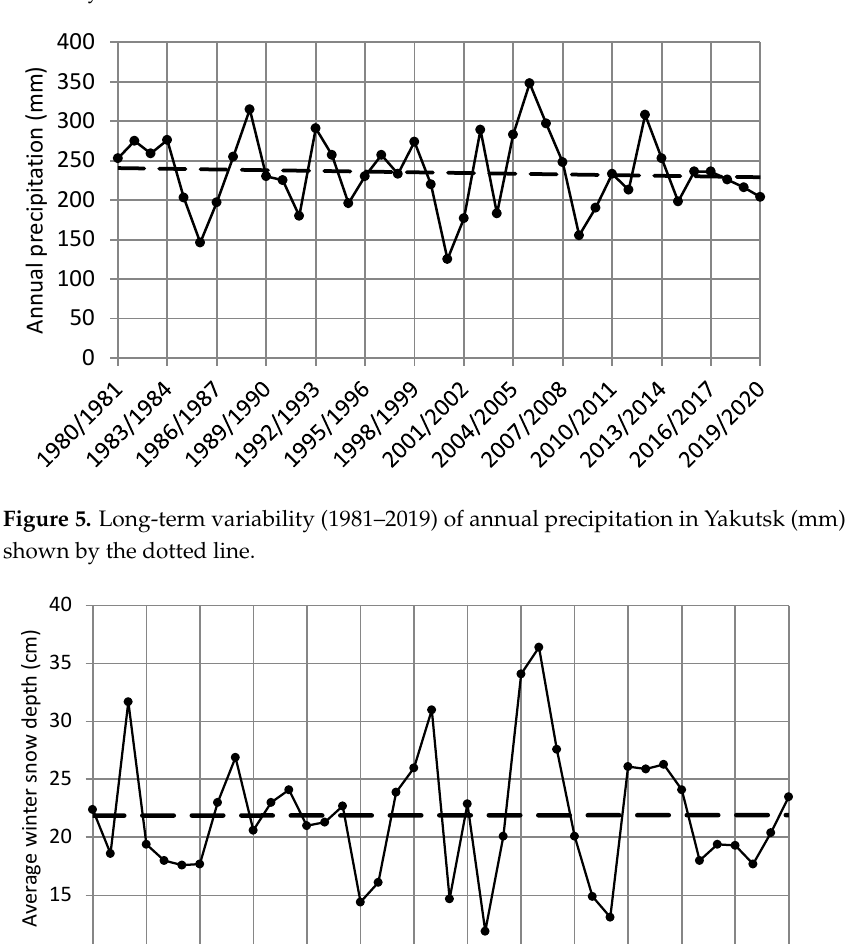
Figure 4. Long-term variability (1981 – 2019) of mean annual air temperature in Yakutsk. Linear trend shown by the dotted line.